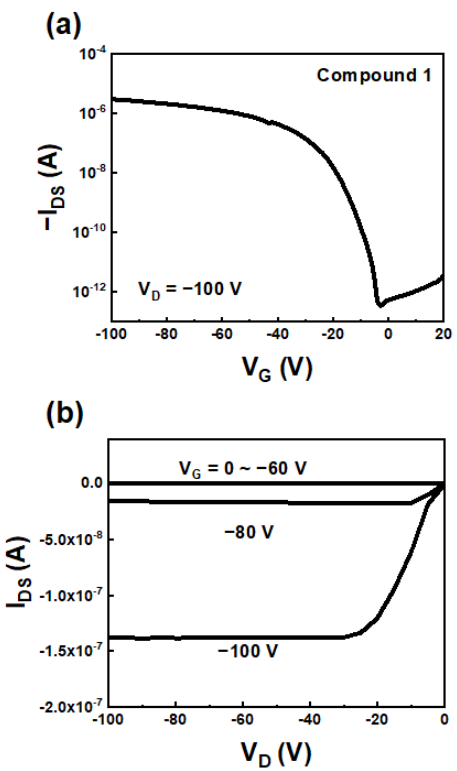
Figure 4. ( a ) Transfer and ( b ) output characteristics of the OFETs based on Compound 1 .